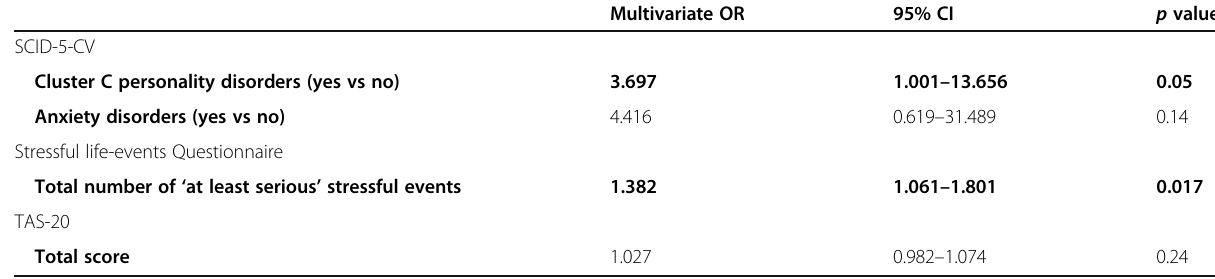
Table 4 Model fit of logistic regression equations to predict erenumab failure (including Cluster C personality